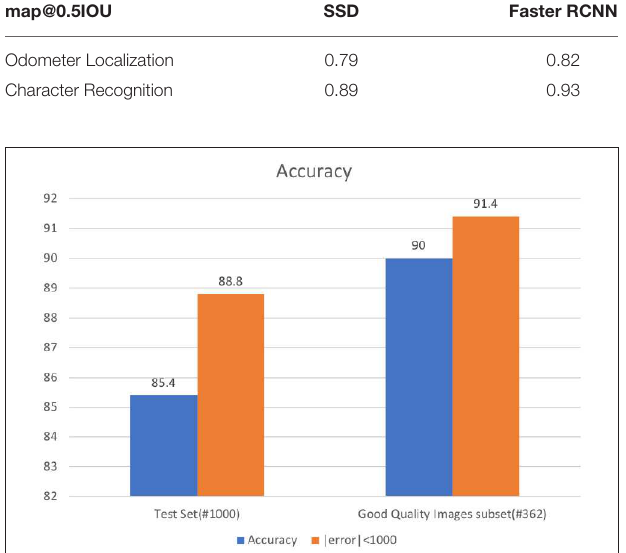
TABLE 3 | Mean Average Precision of Faster RCNN and SSD architectures for odometer localization and character recognition stage. map 0.5IOU